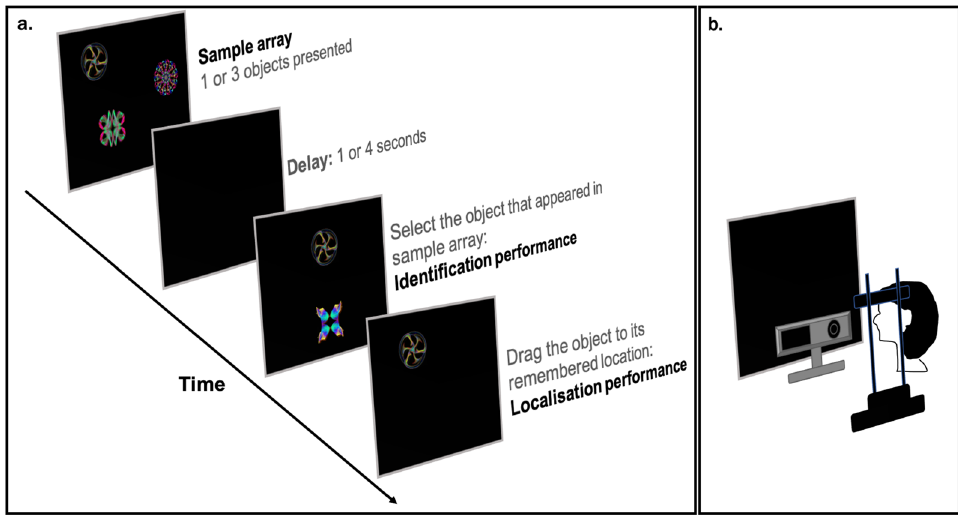
Figure 1. ( a ) Schematic of “Object-localisation” task 21 with identification and localisation measures